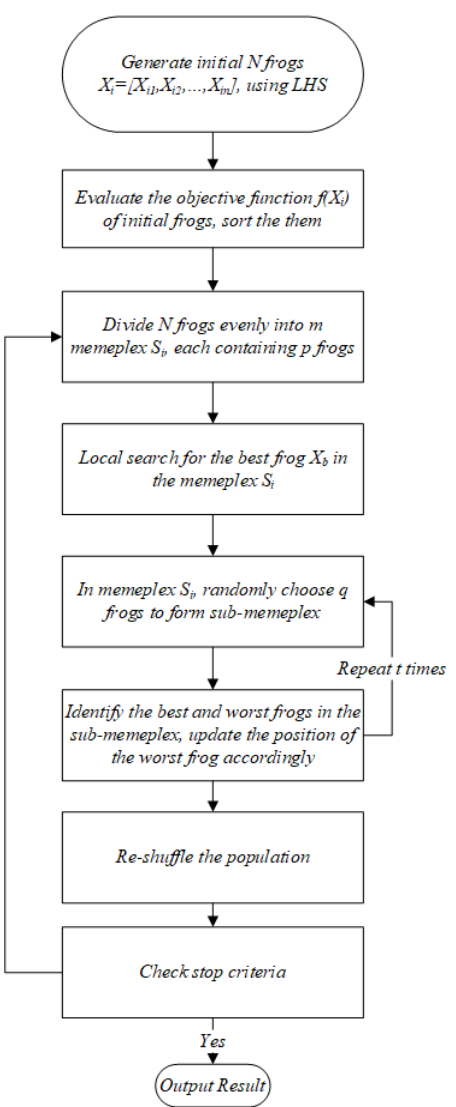
Figure 1. Flowchart of the shuffled frog leaping algorithm (SFLA).